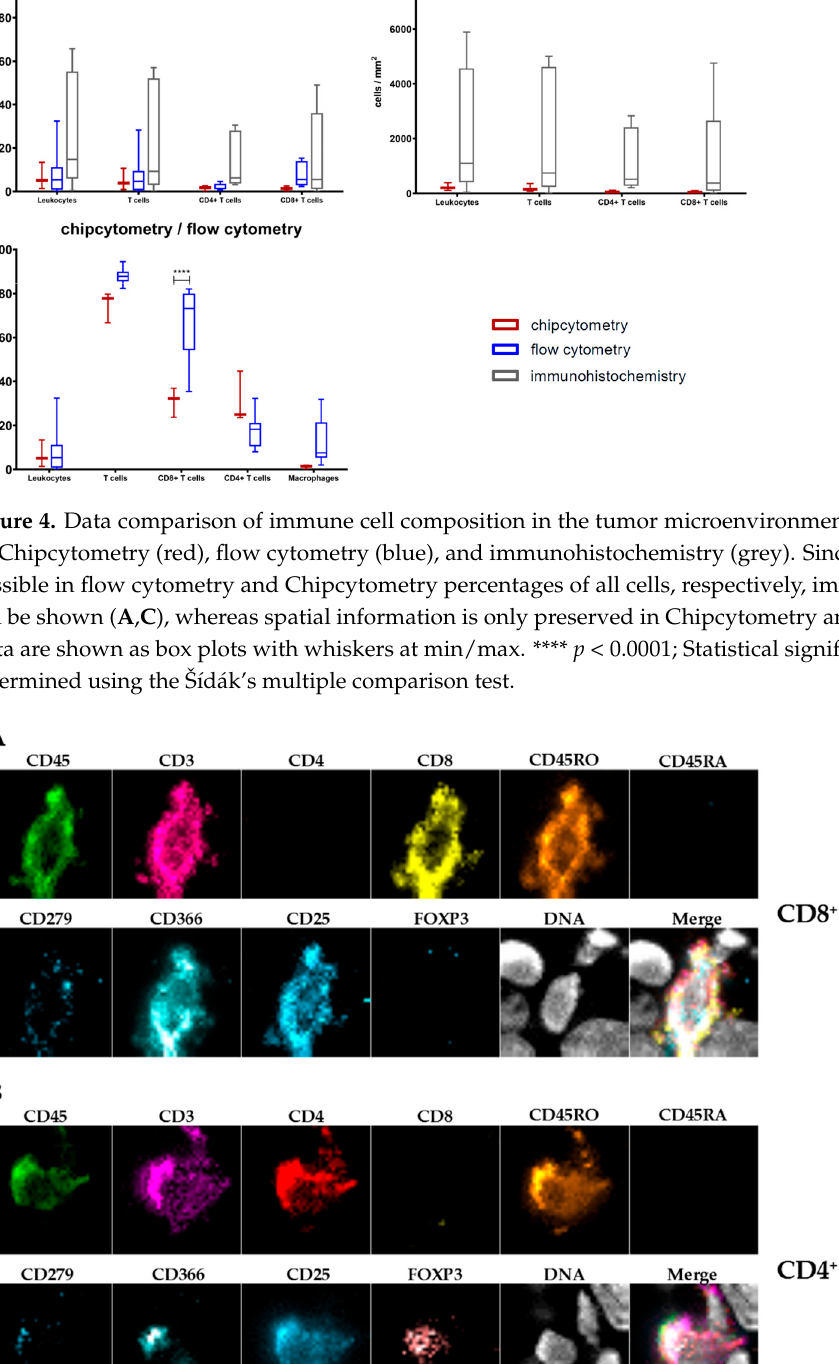
Table 1. Immune cell subpopulations in untreated tumor-bearing animals detected by Chipcytometry (n = 3). Marker Definition Figure 5. Chipcytometry analysis showing exemplarily the identification of tumor-infiltrating CD8 + ( A ) and CD4 + ( B ) T cells within their spatial context. The lower right picture shows the merged channels.